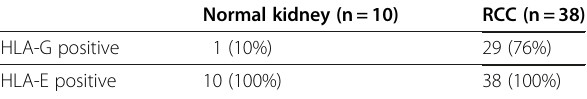
Table 3 Percentages of HLA-G and HLA-E in normal renal parenchyma and RCC tissues